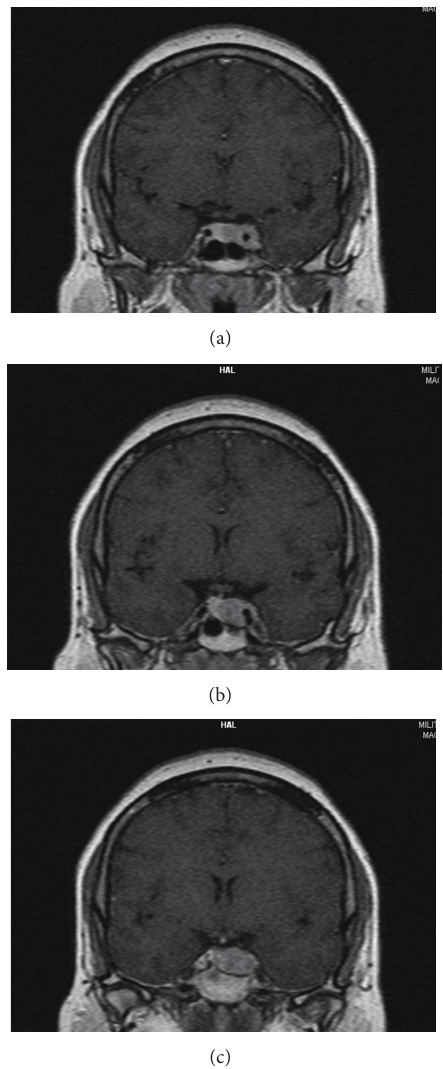
F 1: Postcontrast T1 weighted MRI at the time of diagnosis: coronal sections visualizing pituitary macroadenoma with the le cavernous sinus invasion.